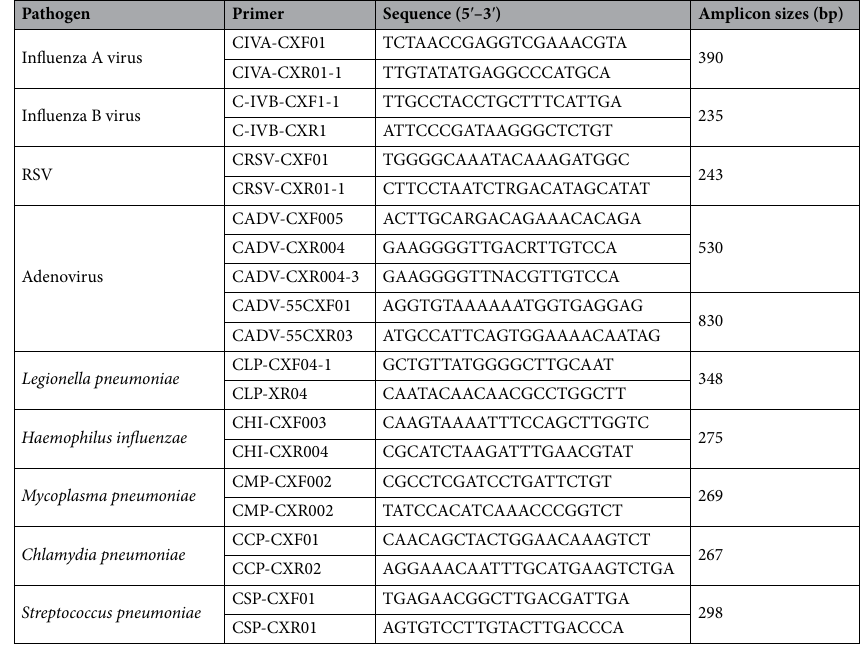
Table 8. Sequences of PCR primers for DNA